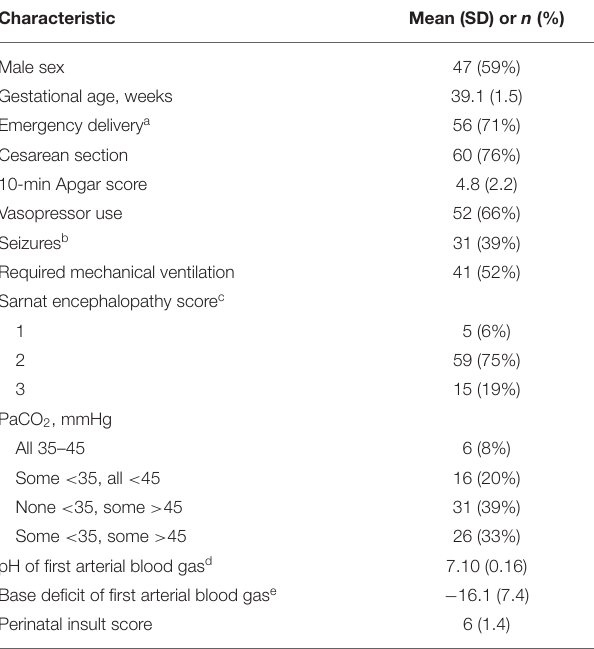
TABLE 1 | Clinical descriptions of neonates ( n = 79). TABLE 2 | MRI interpretation by brain region and National Institute of Child Health